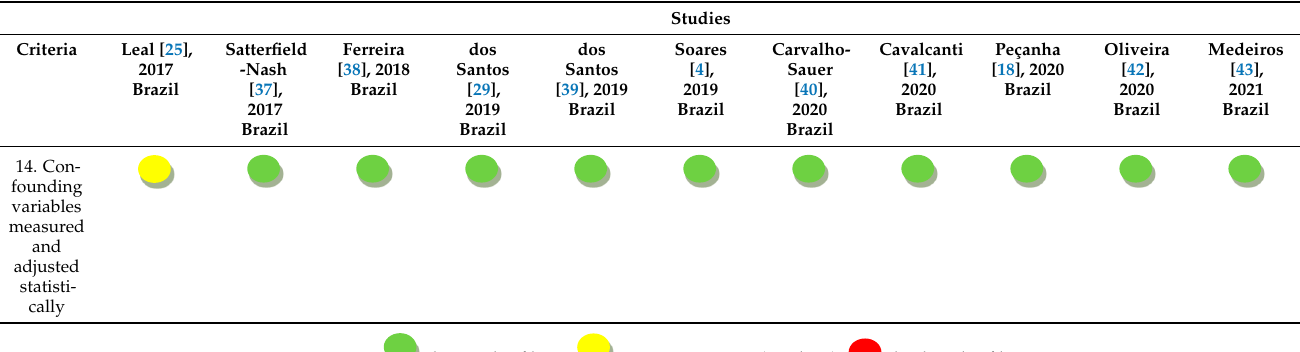
Table 1. Methodological quality and risk of bias of included articles.